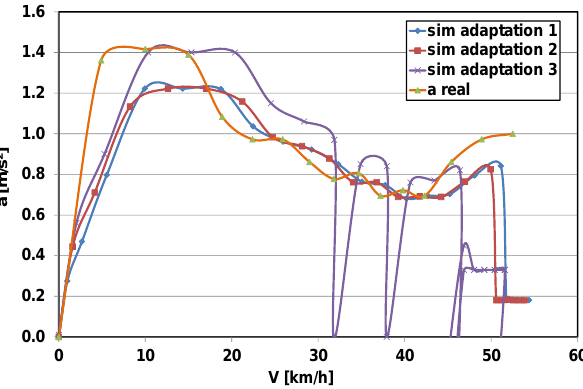
Fig. 4. The process of adaptation characteristics of acceleration of the vehicle in PTV